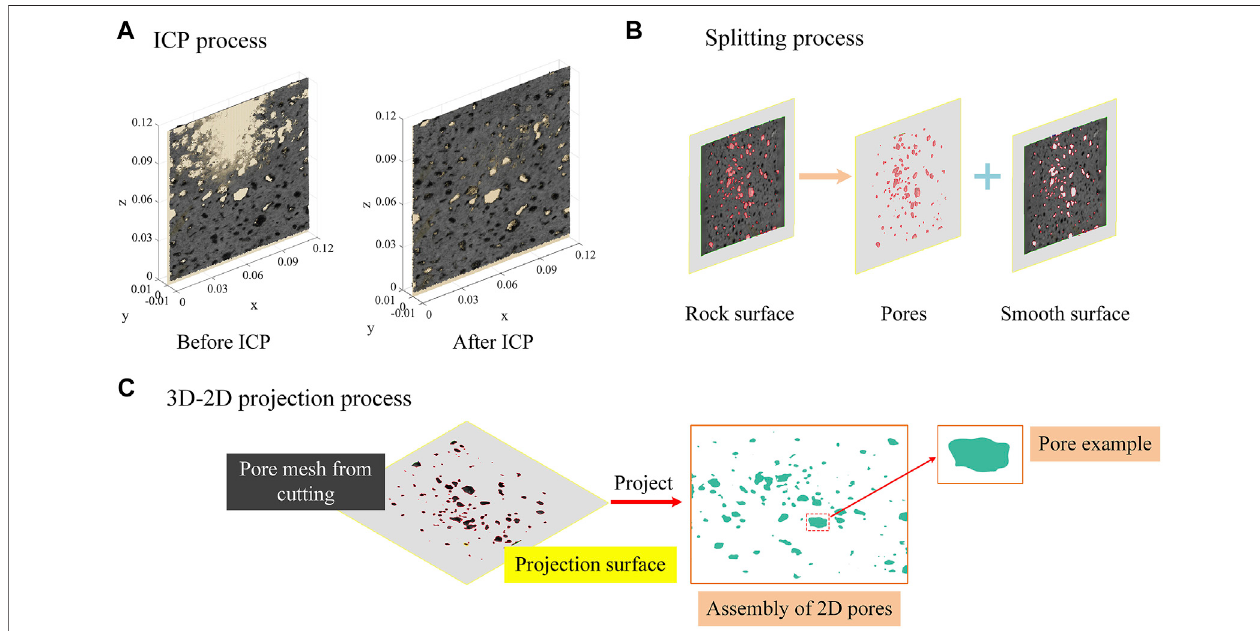
FIGURE 3 | Schematic diagram of processes for rock pore extraction after obtaining the 3D model: (A) tilt correction based on ICP algorithm; (B) process of splitting the pores and smooth surface; (C) 3D-to-2D projection process of rock pores.